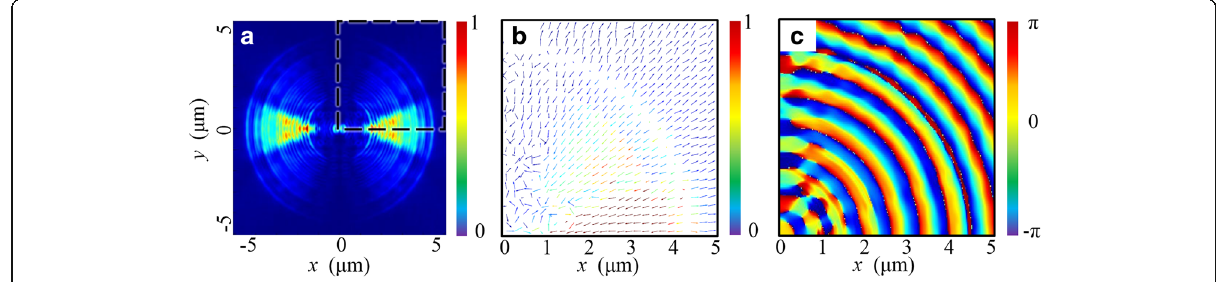
Fig. 5 The electric-field distribution properties in the cross section just 50 nm above the end surface of the lens. a Normalized intensity distribution of | E | 2 . b The Poynting-vector distribution within the dashed-line region in a. c The corresponding phase distribution of E